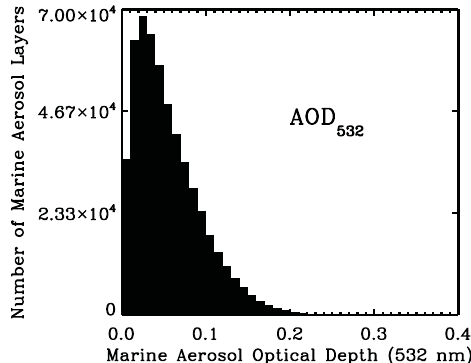
Fig. 2. The CALIPSO lidar marine AOD 532 histogram for 15 se- lected regions over the time period of June 2006 to April